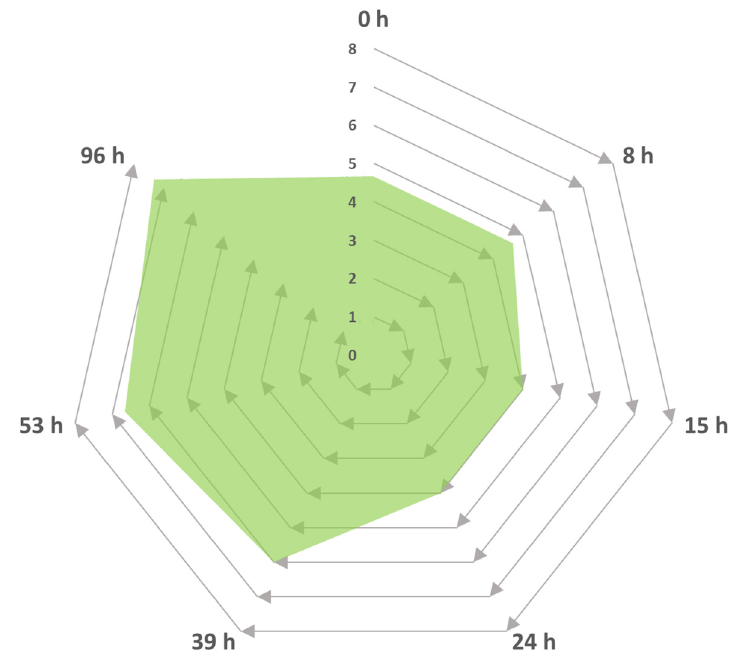
Figure 5. Intensity progress descriptor for the generation of sweet and fruity odours as a function of time by Trametes elegans mycelia cultivated in media containing Cape Gooseberry. The odour intensity